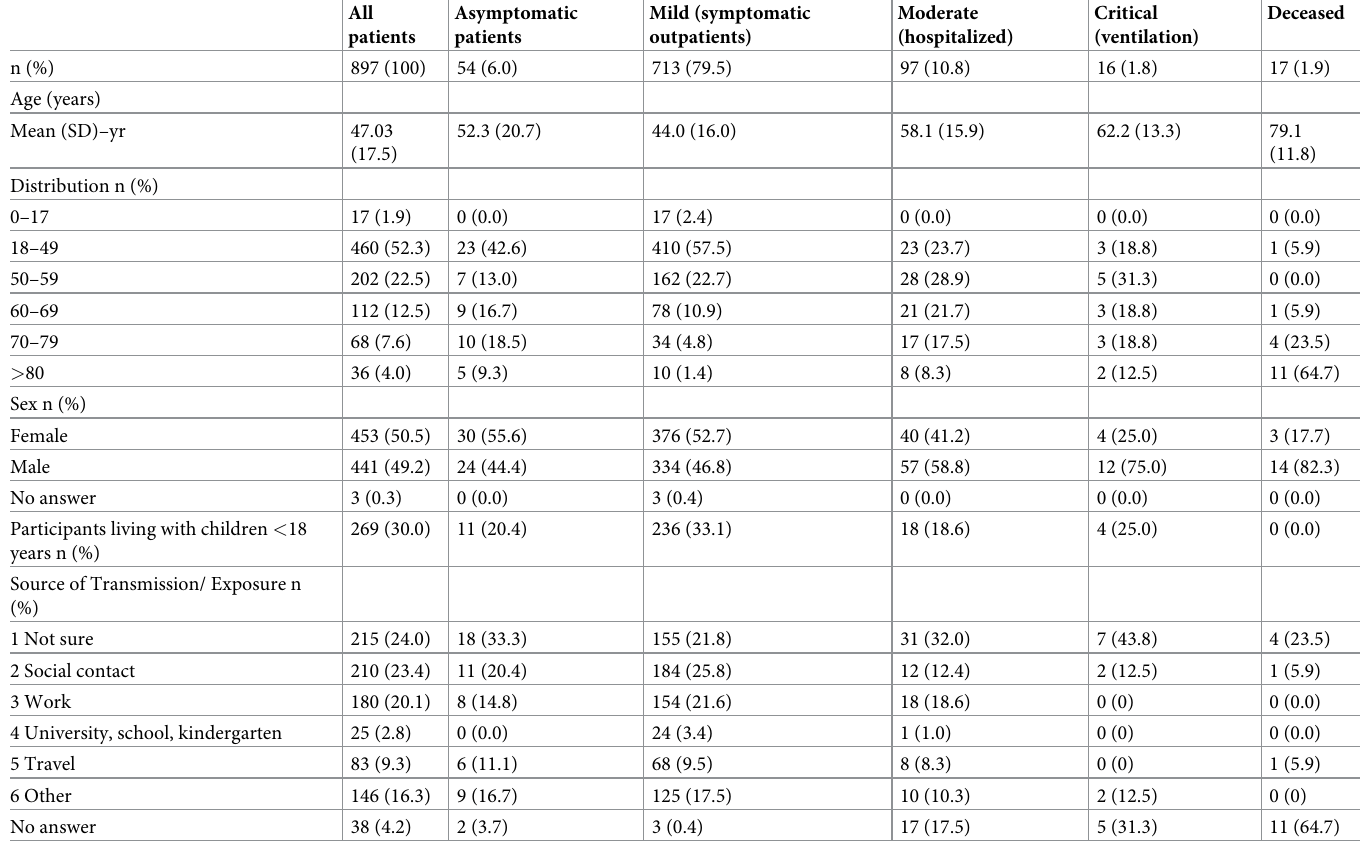
Table 1. Demographics and clinical characteristics.